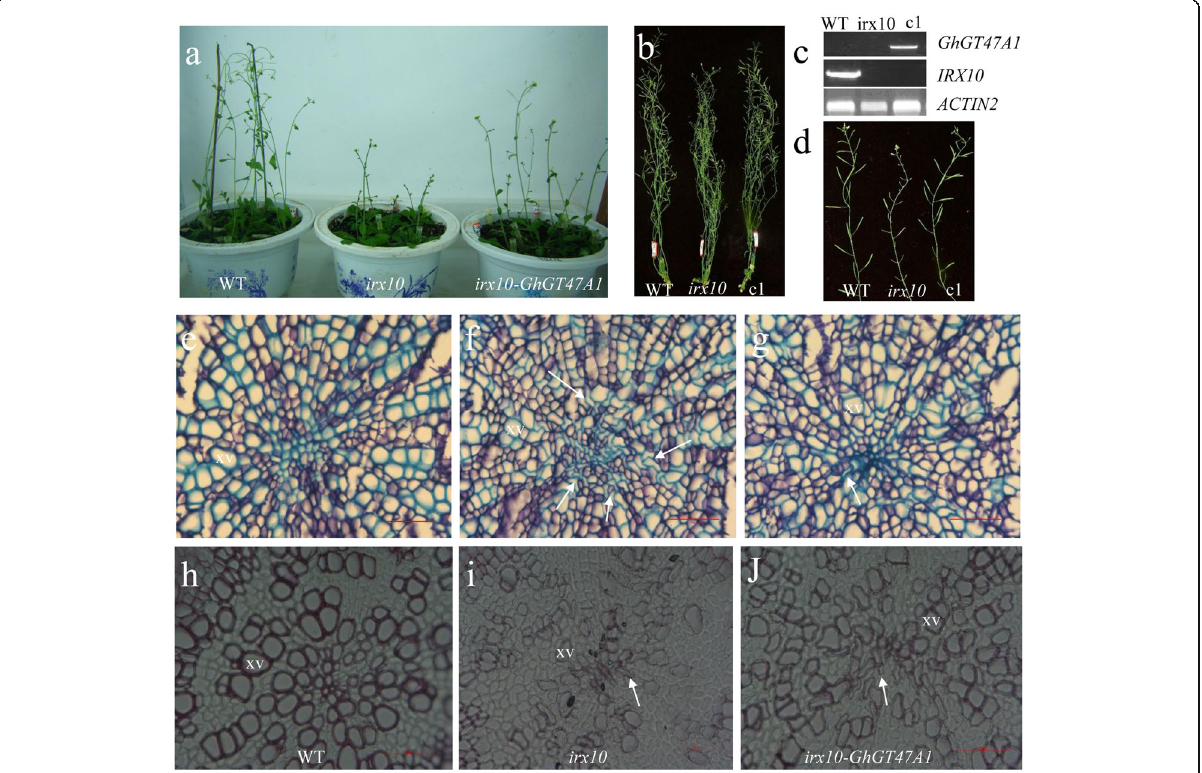
Fig. 4 Expression of GhGT47A1 in Arabidopsis irx10 mutant. a 4-week-old soil-grown wild-type, irx10 , GhGT47A1 complemented irx10 plants. b 6-week-old soil- grown wild-type, irx10 , GhGT47A1 complemented irx10 plants. C1 represents GhGT47A1 complemented irx10 plants. c RT-PCR analysis of expression of the GhGT47A1 , IRX10 in inflorescence stems of wild type, irx10 , GhGT47A1 complemented irx10 plants. C1 represents GhGT47A1 complemented irx10 plants. The expression level of ACTIN2 gene was used as an internal control. d Representative image of a branch carrying siliques from different genotypes. C1 represents GhGT47A1 complemented irx10 plants. e-g Toluidine-blue staining of cross sections of roots from wild type (E), irx10 (F), and GhGT47A1 complemented irx10 plants(G). xv denotes xylem vessel, white arrows indicate collapsed xylem vessels. Scale bar=50 μ m. h-j Phloroglucinol staining of cross sections of roots from wild type (H), irx10 (I), and GhGT47A1 complemented irx10 plants (J) . xv denotes xylem vessel, white arrows indicate collapsed xylem vessels. WT represents wild type, irx10 represents irx10 mutant, c1 represents GhGT47A1 complemented irx10 line. Scale bar=50 μ